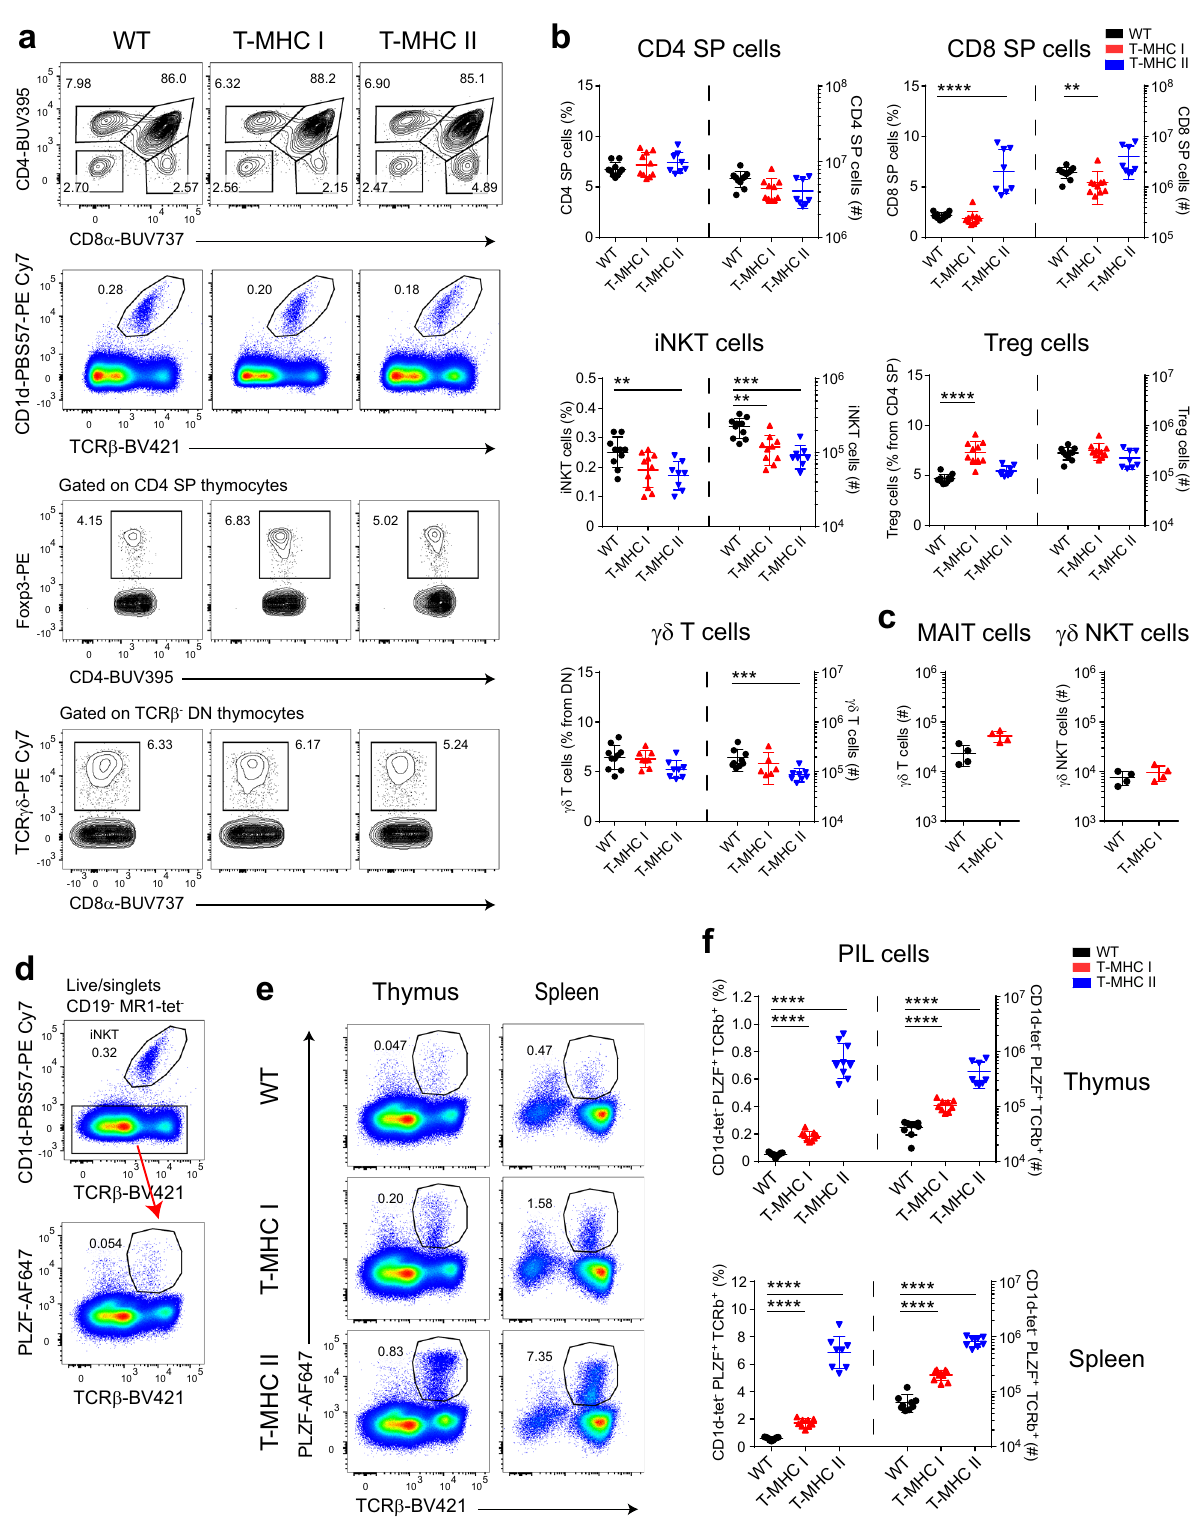
Fig. 1b). In contrast, gene expression of non-peptide presenting molecules CD1d and MR1 is high in DP thymocytes (Supple- mentary Fig. 1e) and was not altered by overexpression of Nlrc5 (Supplementary Fig. 1c). This suggests that peptide presentation through MHC Ia/Ib molecules, in particular, is absent in cortical DP thymocytes due to the absence of Nlrc5 expression, whereas lipid and metabolite presentation are